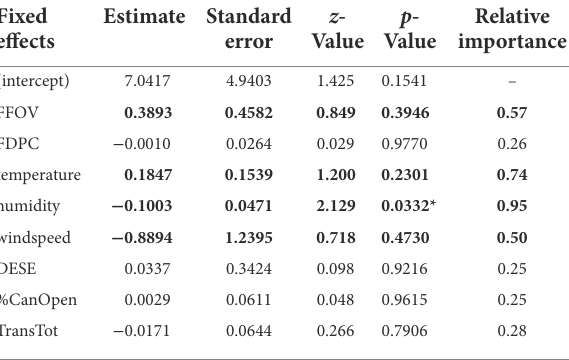
TABLE 4 Model-averaged values for predictors of daily pollinator diversity/RTU Richness throughout the flowering